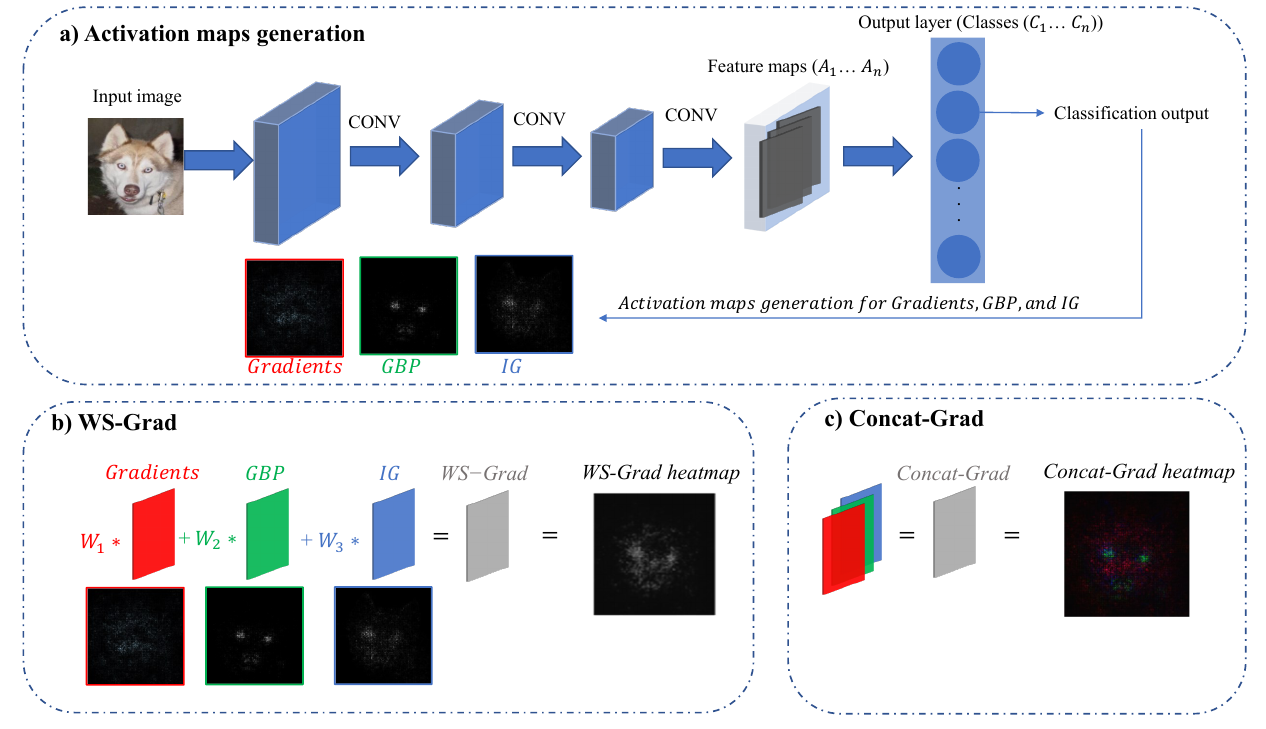
Figure 5. Proposed visualisation approaches using an image from a classification dataset. ( a ) activa- tion maps generation, ( b ) Weighted sum of gradients approach (WS-Grad) and ( c ) Concatenation of gradients approach